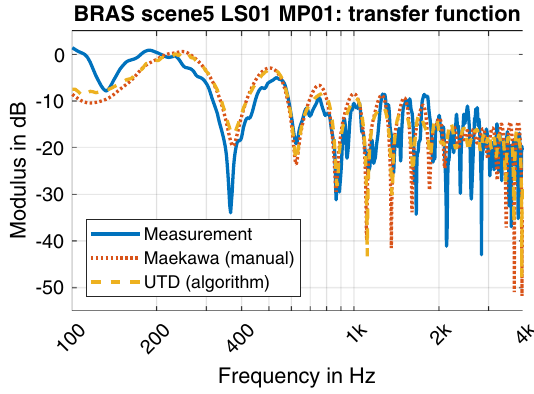
Figure 15. Measurement and simulation results of BRAS scene 5 (LS01, MP01) in the frequency domain [46].